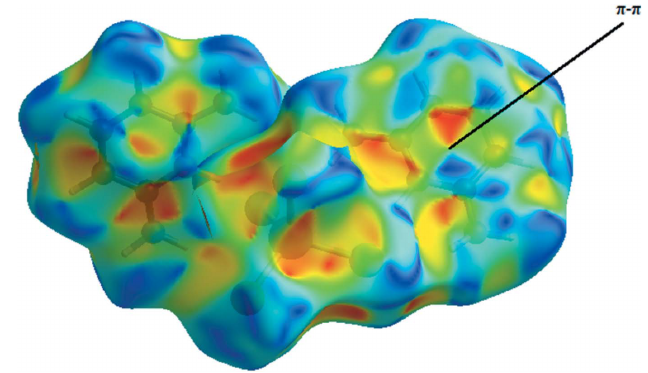
Figure 7 Hirshfeld surface mapped over shape-index, highlighting the regions involved in (cid:2) – (cid:2) stacking interactions.